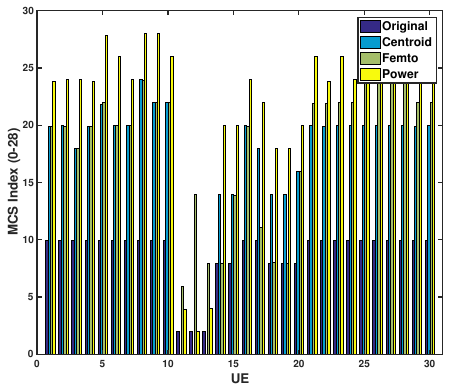
Figure 17. MCS Index vs. Number UEs Figure 18. TBS vs. Number UEs